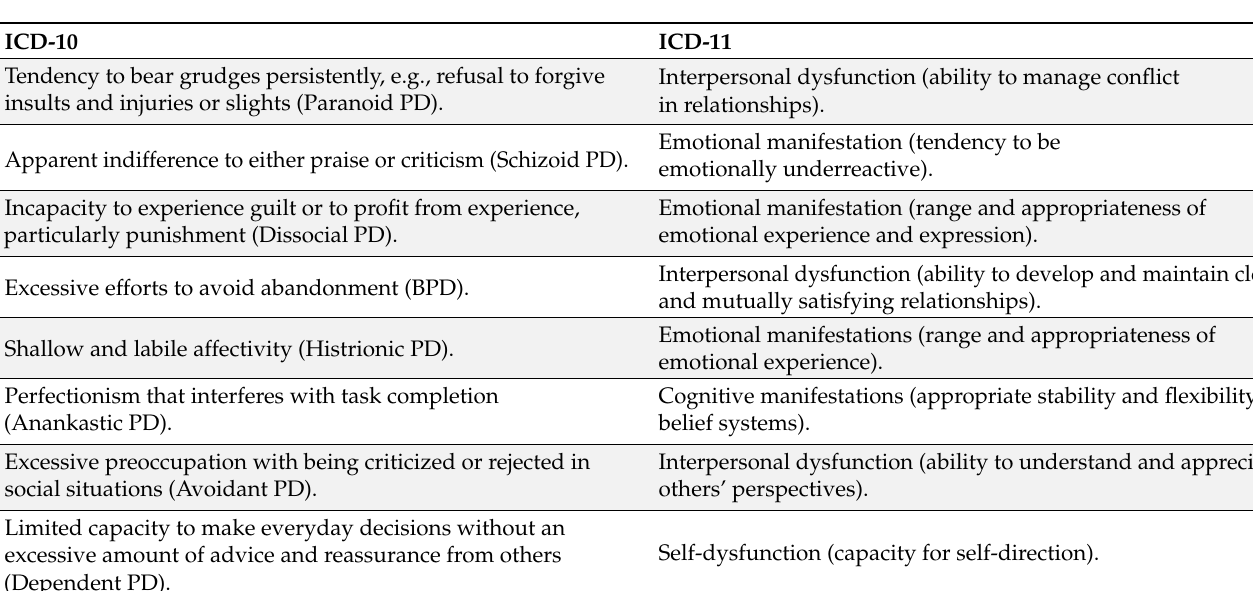
Table 1. A new psychological language for personality disorders: Crosswalk examples between ICD-10 diagnostic categorical criteria and potential aspects determining ICD-11 severity.